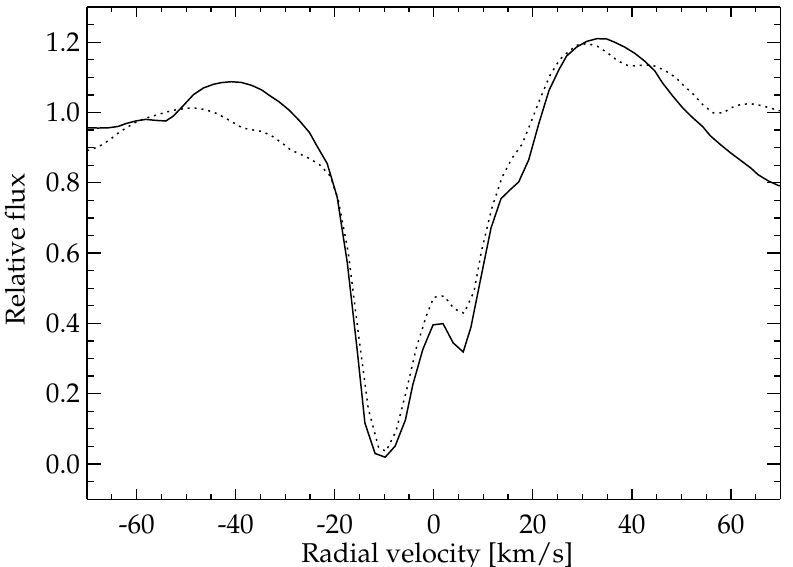
Fig. 2. The Na D doublet in the spectrum of υ Sgr in the velocity scale. The D 2 line is plotted by continuous line, the D 1 { by dotted line. These pro(cid:12)les are from the mean NARVAL spectrum. This mean is calculated from 15 individual spectra obtained during JD 2454635.6 to JD 2454638.6. The radial velocity of υ Sgr at that time was RV (cid:25) 9 km s (cid:0) 1